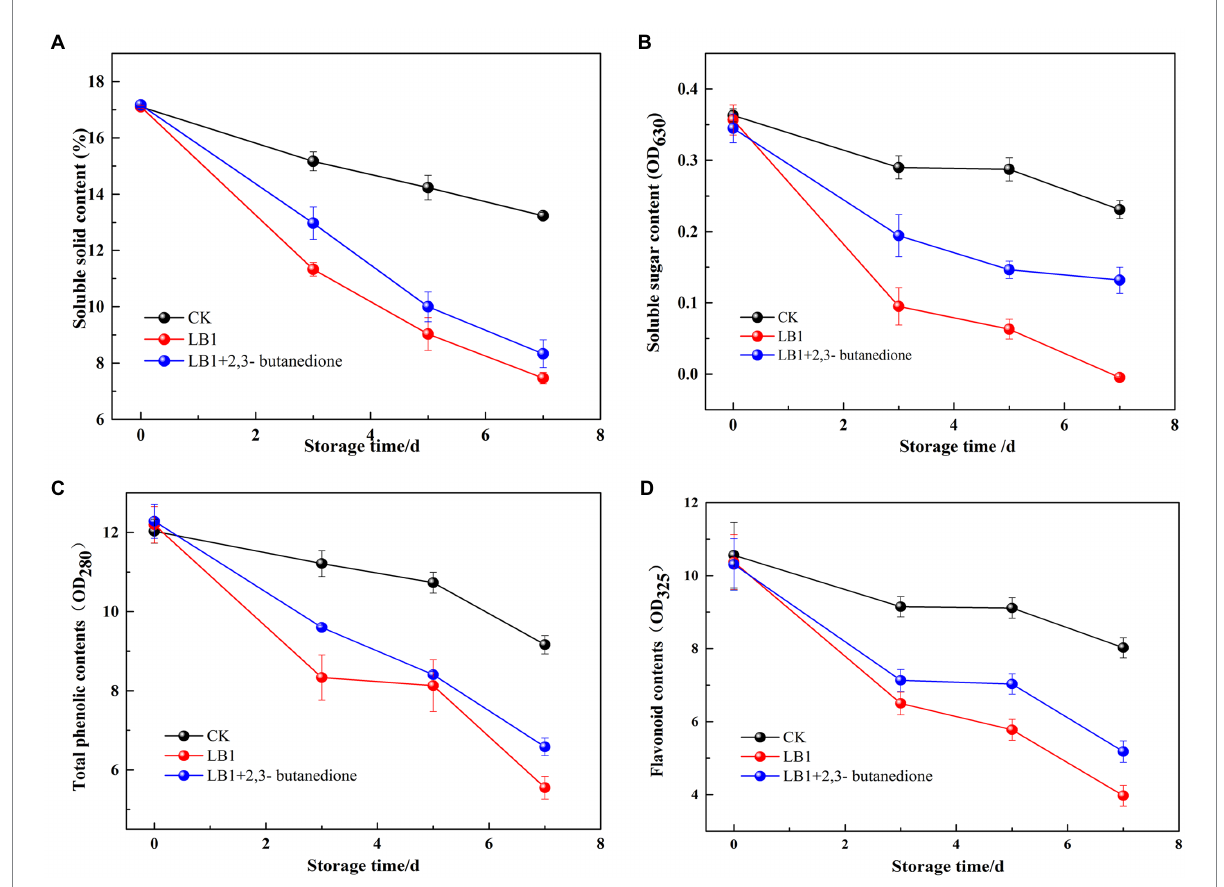
FIGURE 6 Determination of the soluble solids content, total phenols, flavonoids and soluble sugar content of wolfberry fruits after harvest ( A : soluble solids content, B : total phenols, C : flavonoids, D : soluble sugar